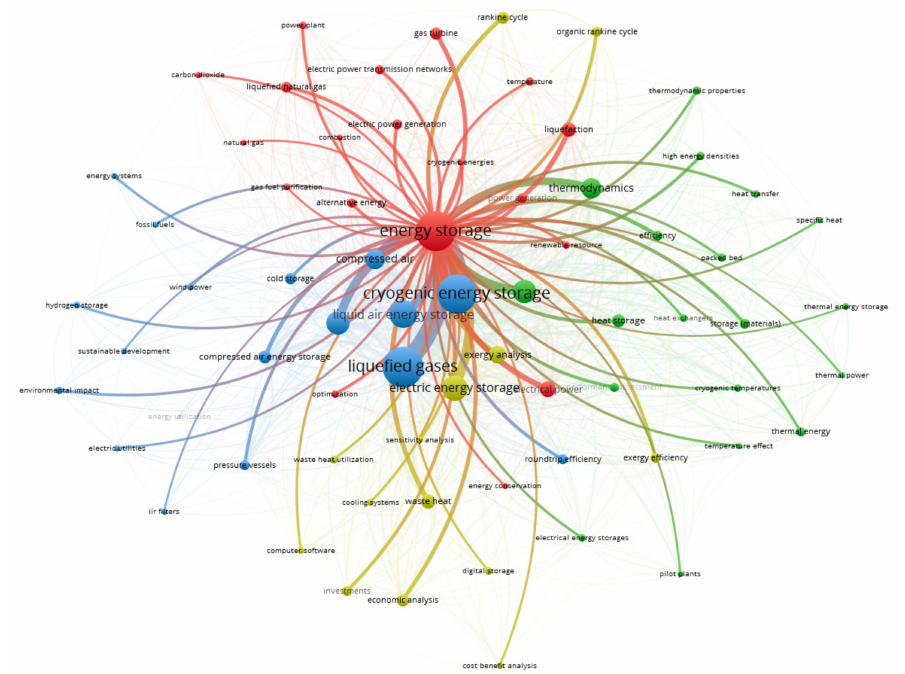
Figure 15. Co-occurrence and link of the keyword “energy storage” elaborated with